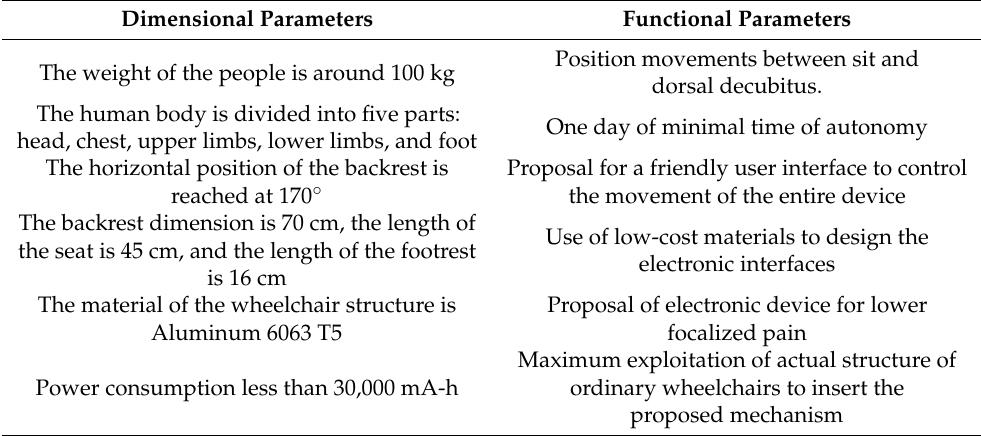
Table 2. Main parameters for wheelchair